Question: In a single sentence, describe what this figure presents.
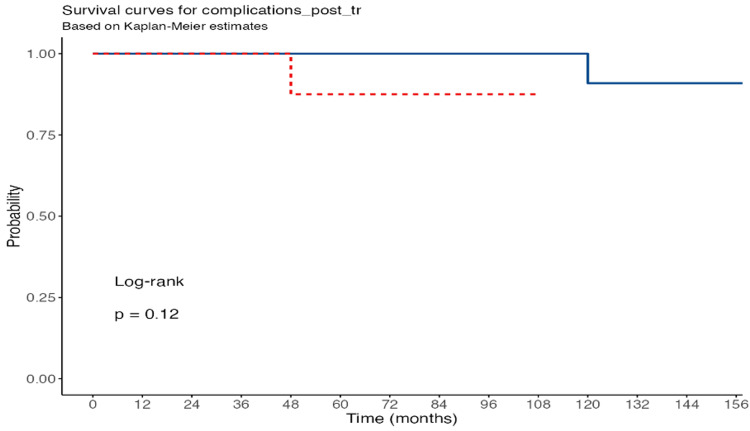
Answer: Kaplan-Meier survival curves according to the occurrence of post-donation complications